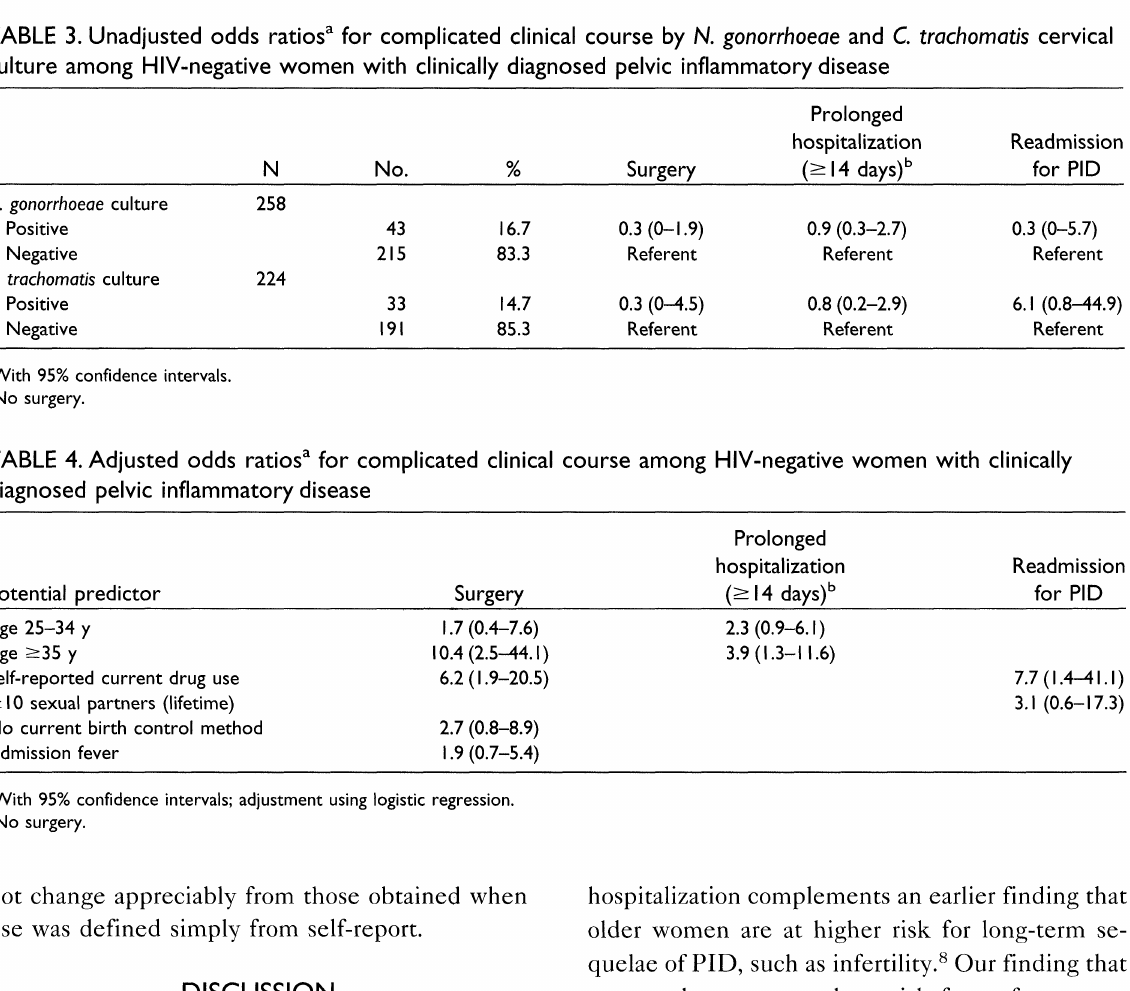
TABLE 3. Unadjusted odds ratios for complicated clinical course by N. gonorrhoeae and C. trachomatis cervical culture among HIV-negative women with clinically diagnosed pelvic inflammatory disease